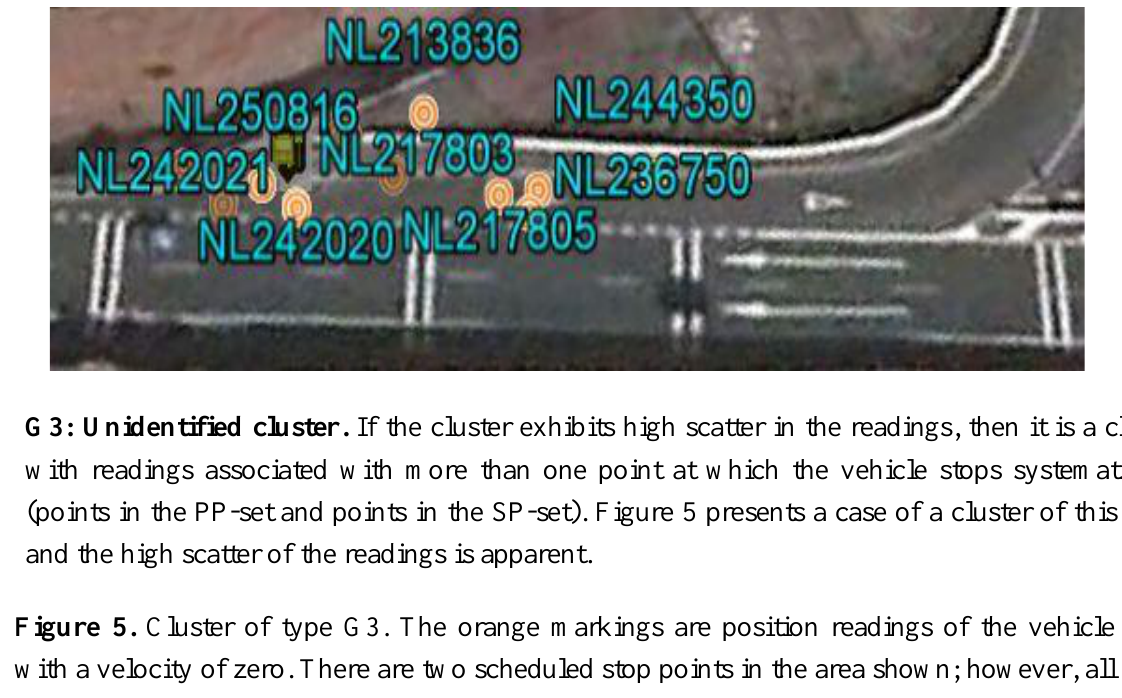
Figure 4. Aerial view of a type G2 cluster. The orange markings represent position readings of the vehicle with zero velocity at a location where no stop is programmed. The vehicle stops because it reaches a road with greater circulation priority. The yellow marking is the centroid of the cluster.